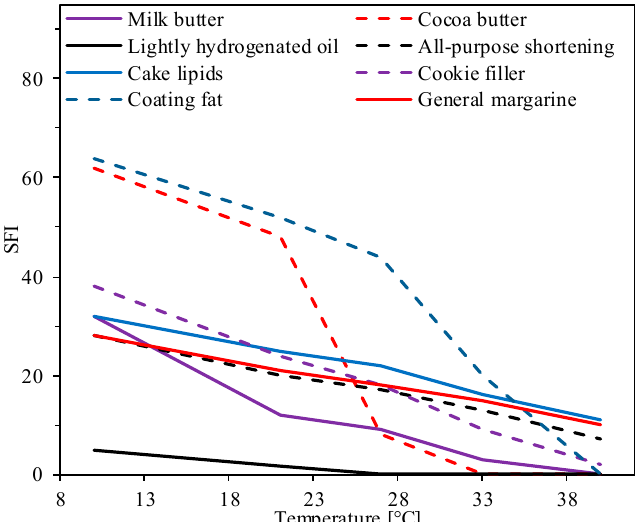
Figure 1. Solid fat index (SFI) profile of typical shortenings for bakery products. Notes: The SFI data was adapted from